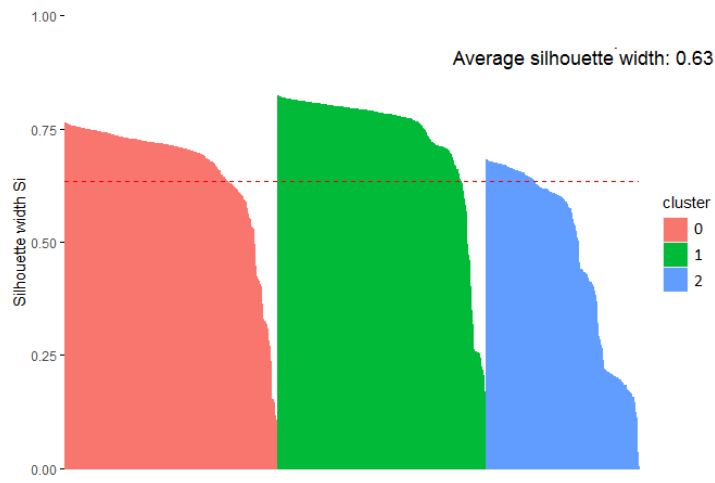
Figure 10. Plot of clustering silhouette coefficients using 3 clusters in indoor dataset.